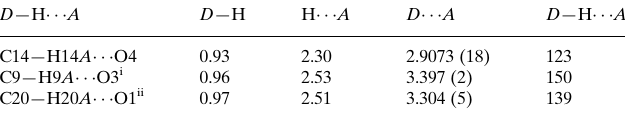
Hydrogen-bond geometry (A˚ , (cid:2)